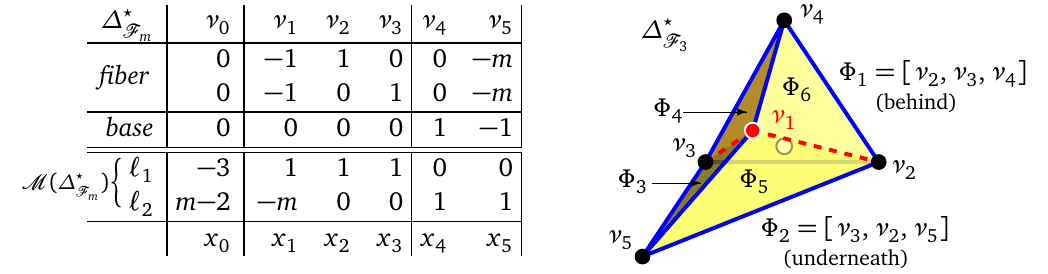
Figure 2: The spanning polytope of the Hirzebruch 3-fold (cid:70) vertices, ν ρ , and Mori vectors, (cid:96) ( x ) are the homogeneous coordinates of the fiber (cid:80) 2 and base (cid:80) 1 , , x 4 5